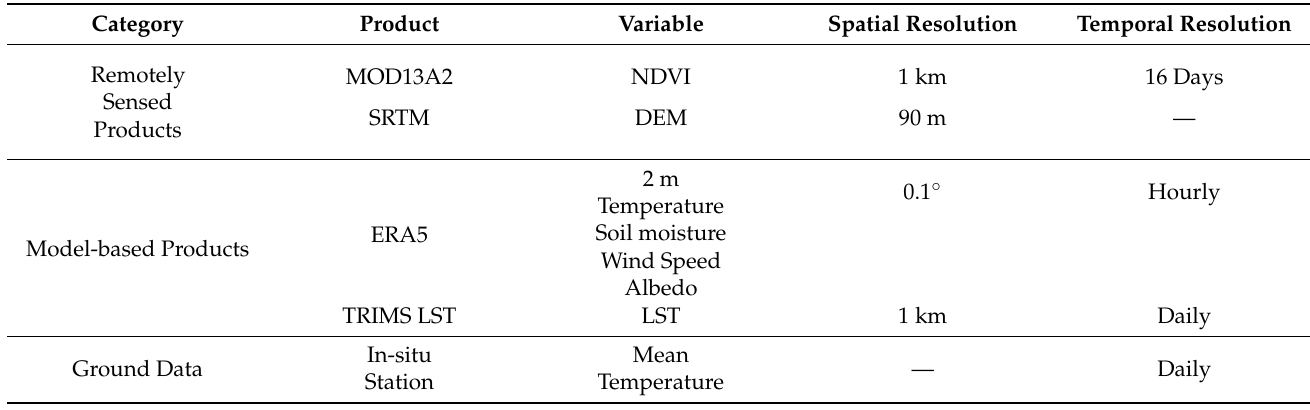
Table 1. The detailed information of three categories of products used in this